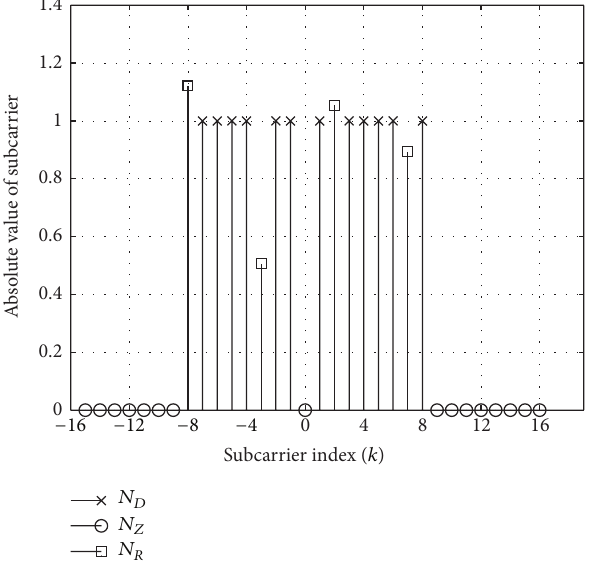
Figure 7: Subcarrier index notation.